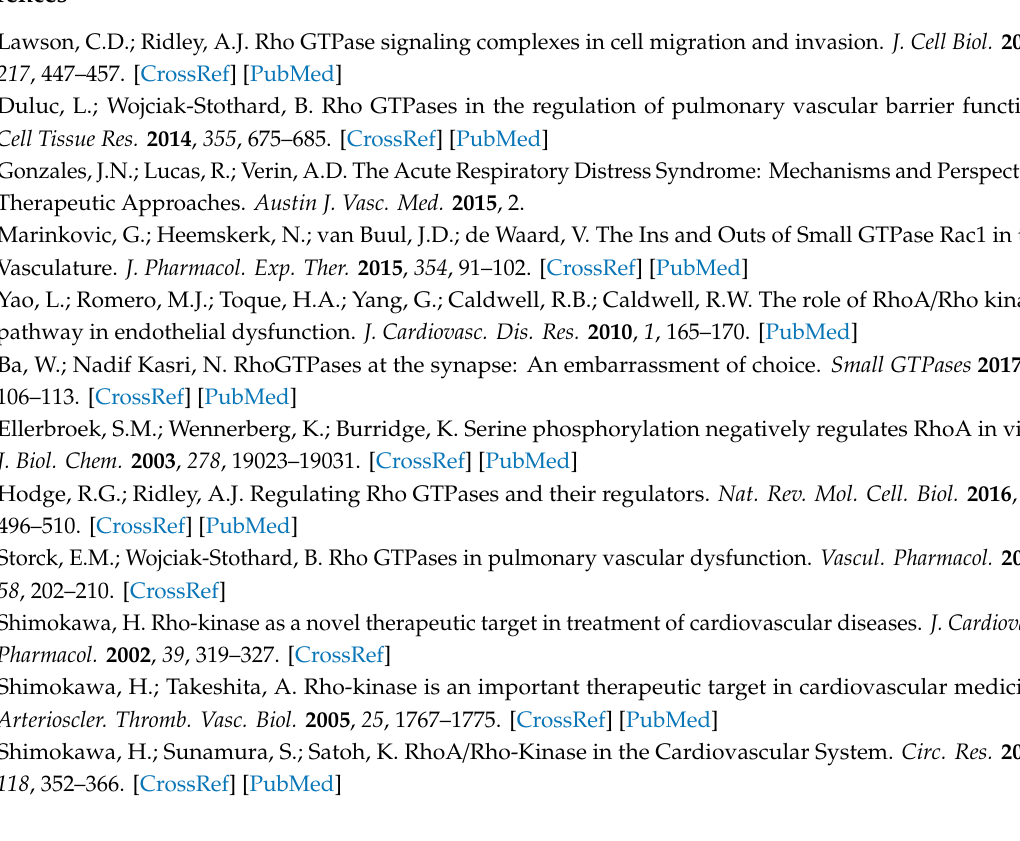
Table 1. Cont. Trial Drug Multi-faceted Evaluations Following Weight Reduction in Subjects With Metabolic Syndrome Rho Kinase in Patients With Atherosclerosis ROCK biomarker Anti-Hypertensive Agent (ACEi) and Heart Function Improvement in Association With Rho Kinase Activity Changes in Human